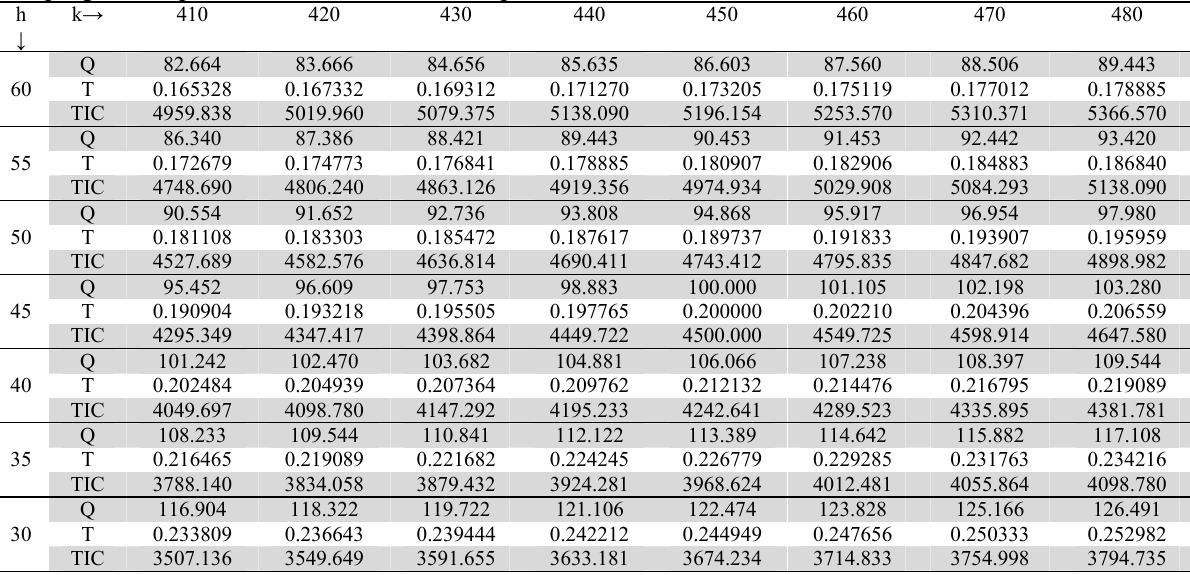
Variation of optimal solution of Q = Q keeping all the parameters same as in Example